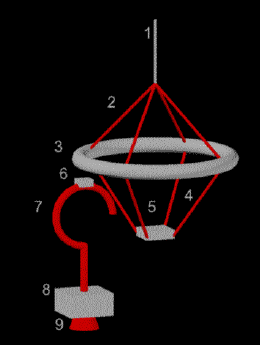
Figure 8. A tentative hook-and-loop catch mechanism for LEO bolos. (1)